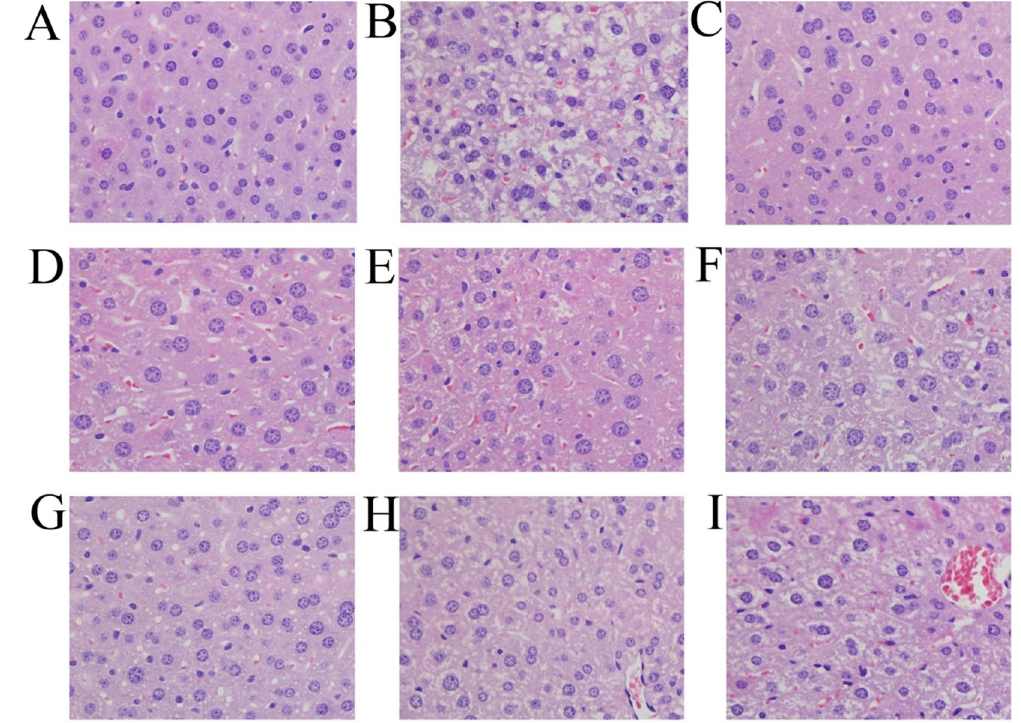
Figure 6. Optical micrographs of mouse liver sections (400 × magnification). Liver sections from mice in the normal saline group ( A ), high-fat emulsion group ( B ), simvastatin group ( C ), and groups treated with100, 200 and 400 mg/kg body weight EPS ( D – F ) of DEPS ( G – I